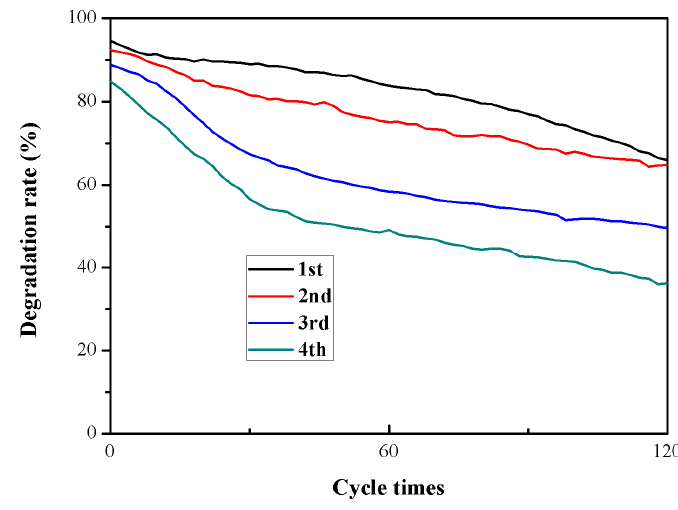
Figure 13. Reusing performance of catalyst.